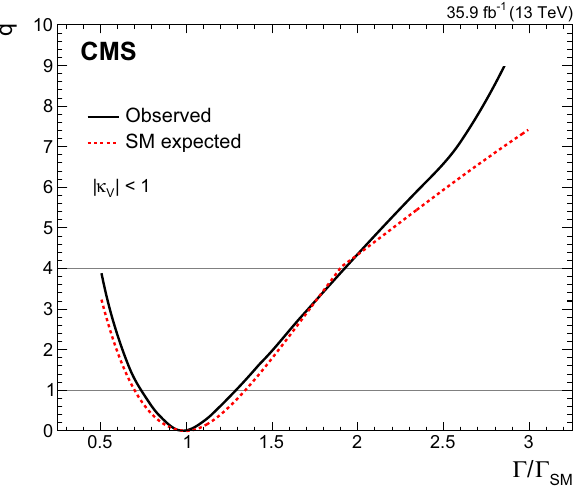
Fig. 14 The scan of the test statistic q as a function of Γ H /Γ SM obtained by reinterpreting the model allowing for BSM decays of the Higgsboson.Theexpectedscanof q asafunctionof Γ H /Γ SM the SM is also shown Fig. 15 The 1